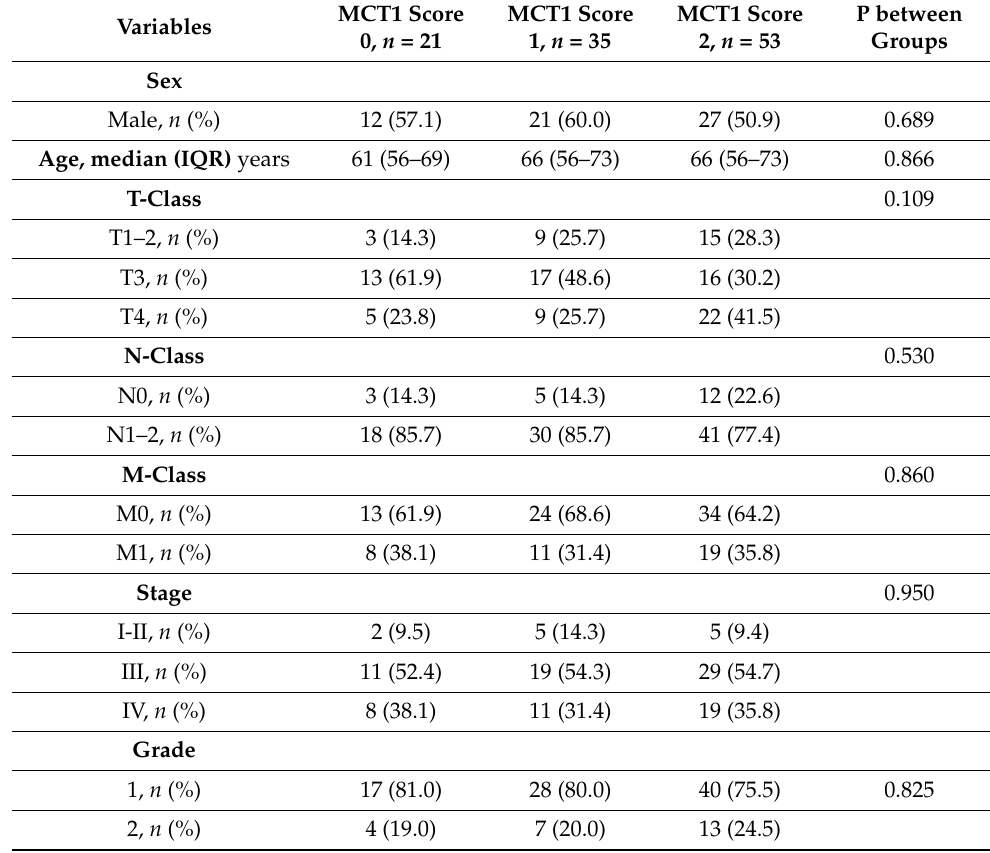
Table 1. Baseline characteristics and comparison stratified by monocarboxylate transporter (MCT) 1